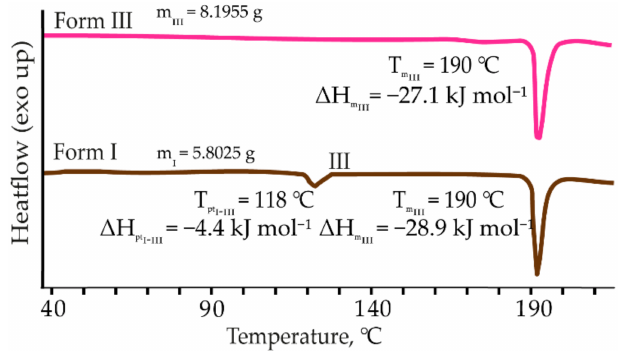
Figure 3. DSC curves of 2,6MeOBA polymorphs I and III (heating rate 10 ◦ C · min − 1 ). The onset temperatures were used to describe each process observed in the DSC